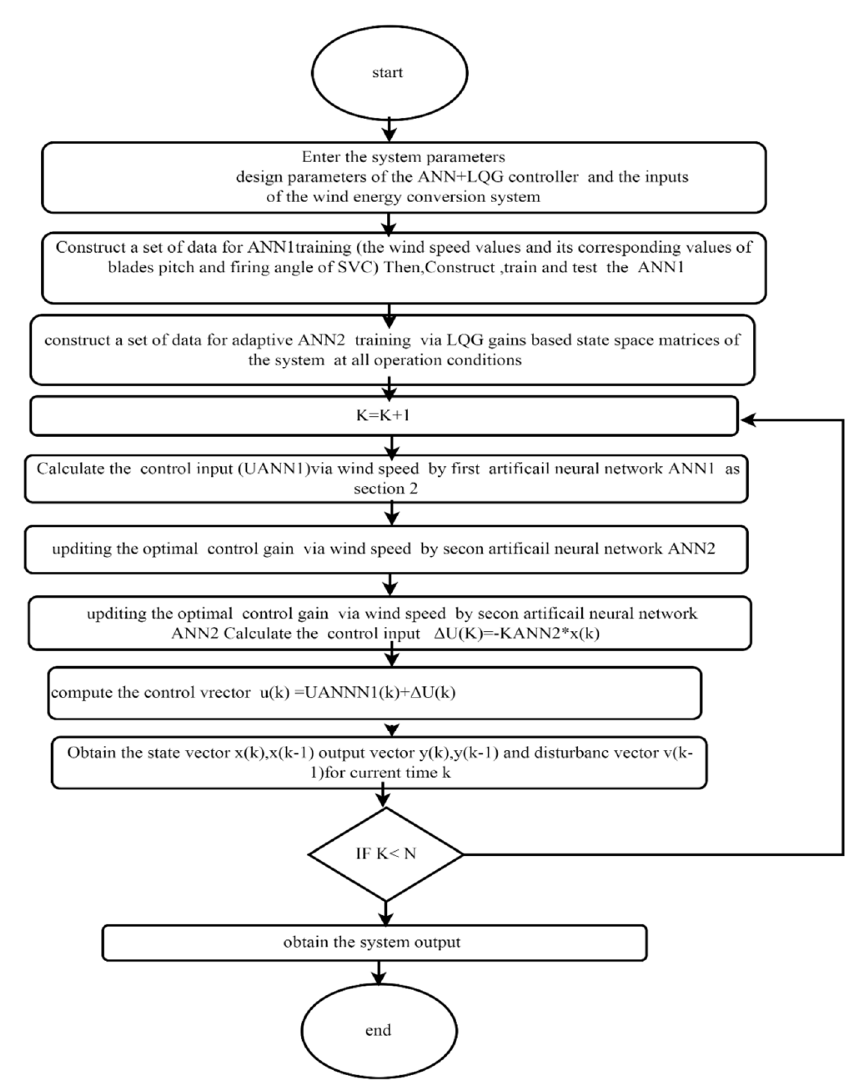
Figure A4. flowchart of ANN-LQG controller. Figure A4. Flowchart of ANN-LQG